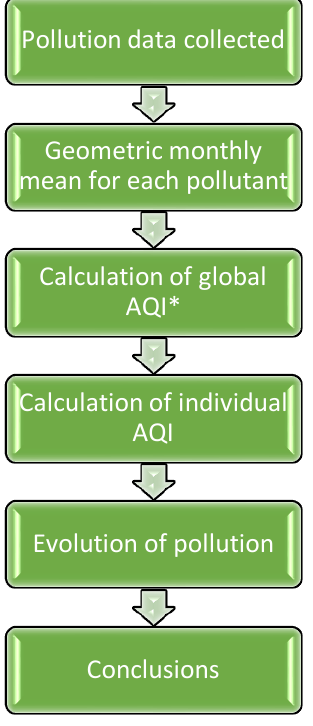
Figure 6. Flowchart of methodology to calculate